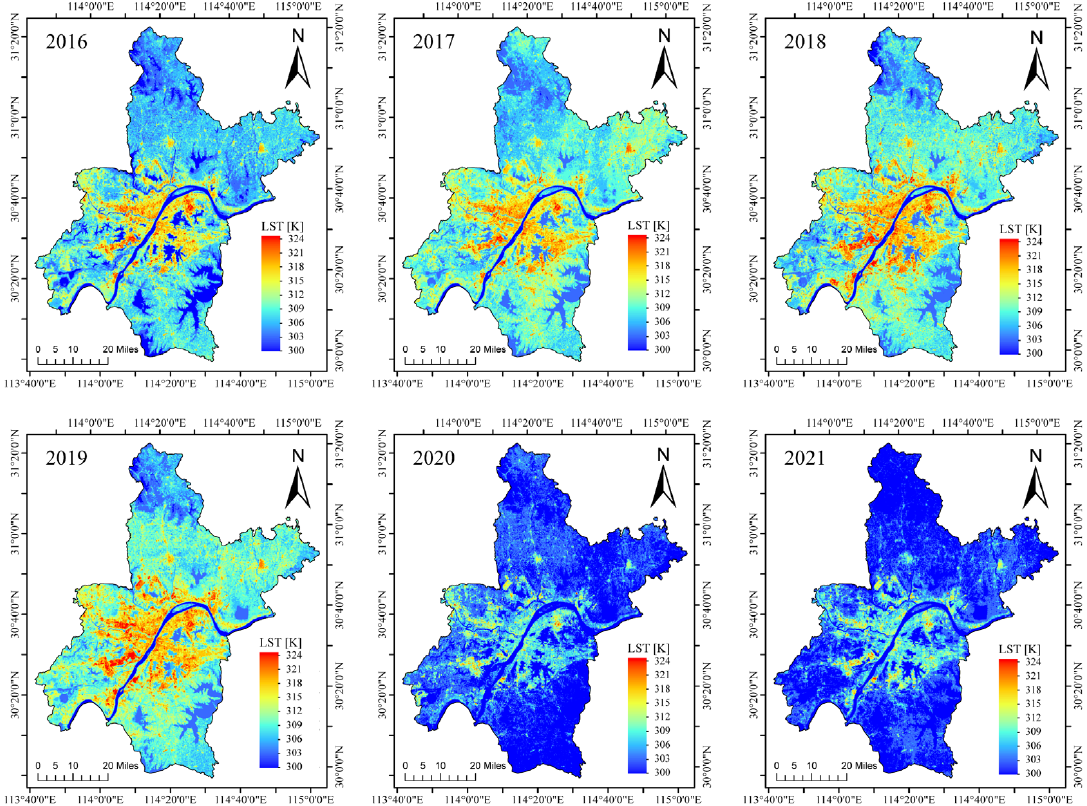
Figure 10. Spatial distribution of the reconstructed summertime LST from 2016 to 2021.